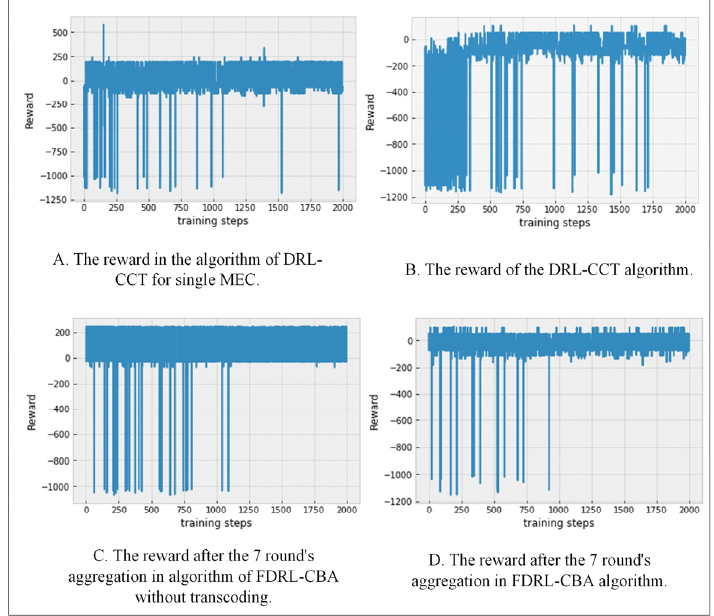
Figure 4. Comparison of the loss performance.